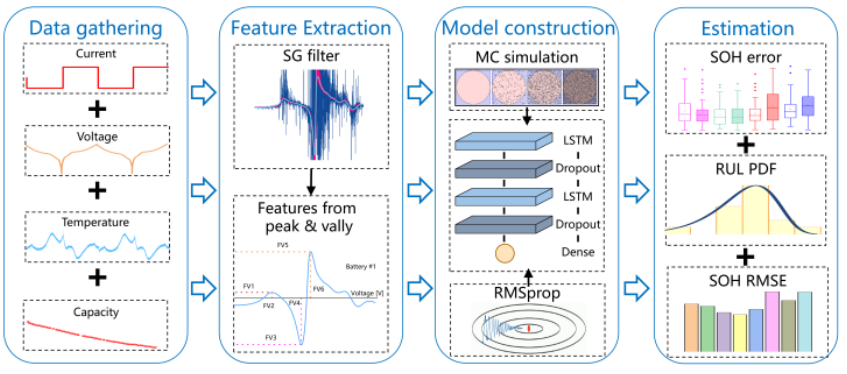
Figure 8. Framework of the proposed RUL and SOH estimation model.